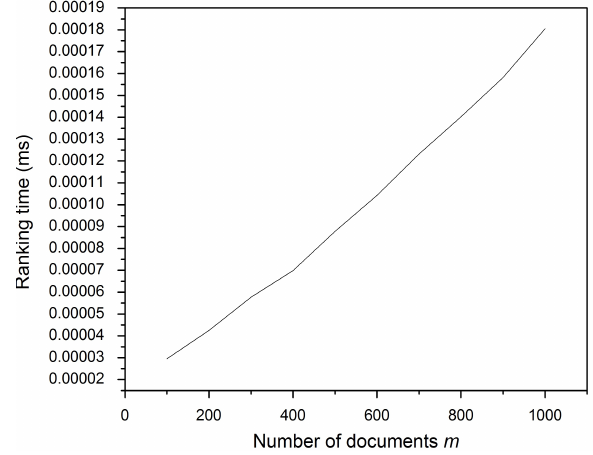
Figure 9. Ranking time: increasing the document collection.